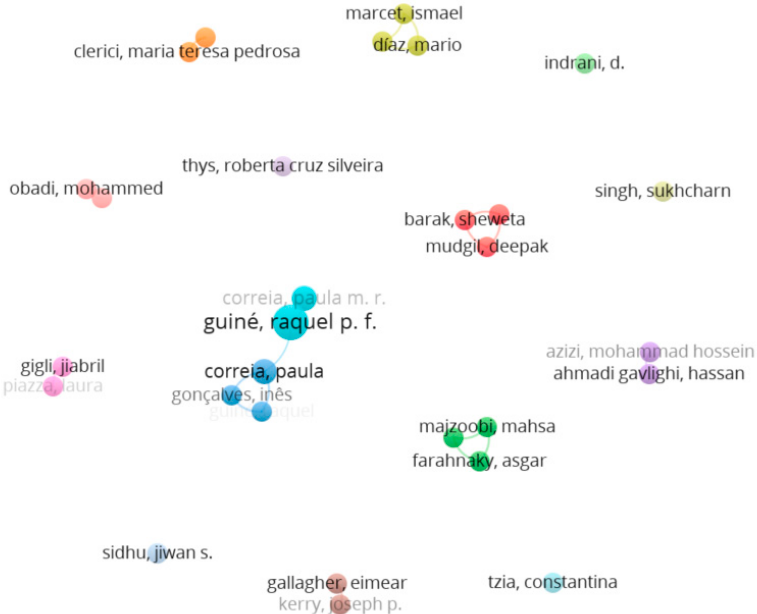
Figure 3. Analysis of co-authorship links between authors, considering those that occurred at least two times.